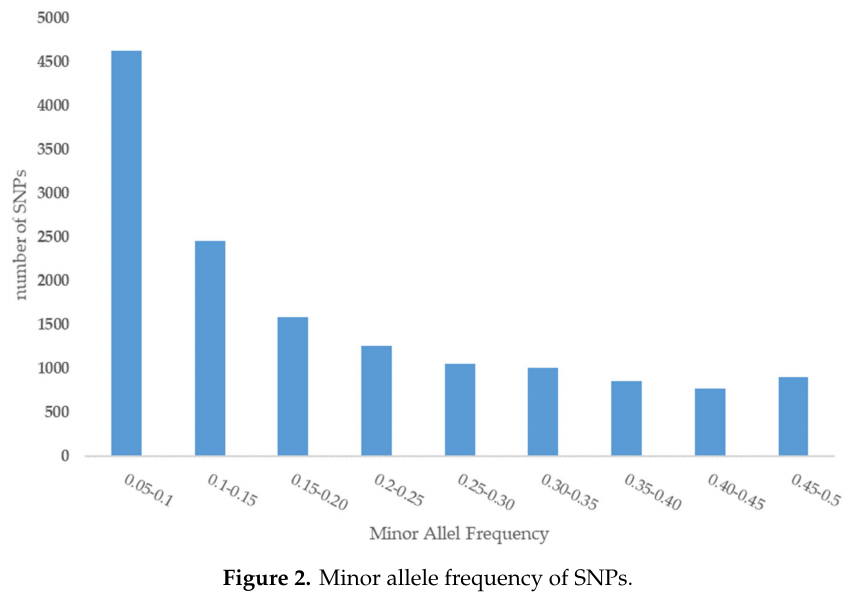
Figure 2. Minor allele frequency of SNPs.